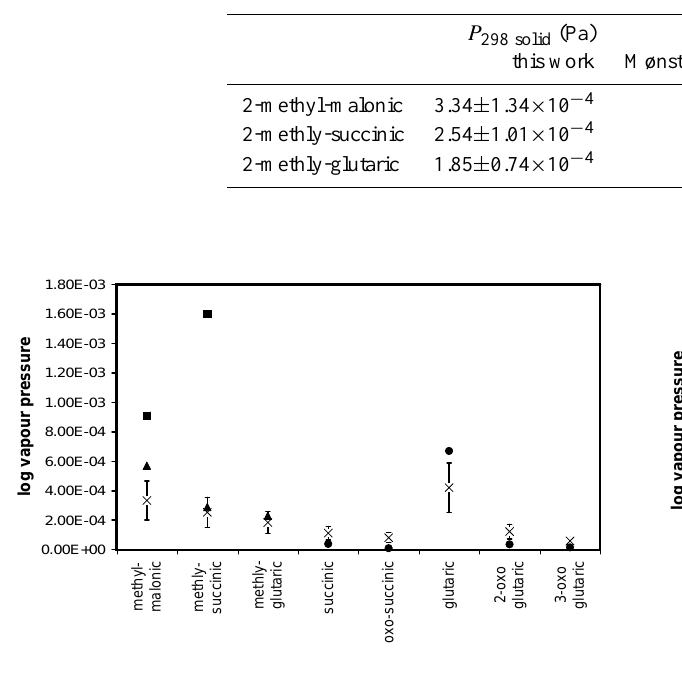
Fig. 4. Comparison of sub-cooled liquid vapour pressure at 298K in Pa. Symbols; × KEMS, (cid:4) Riipinen et al.